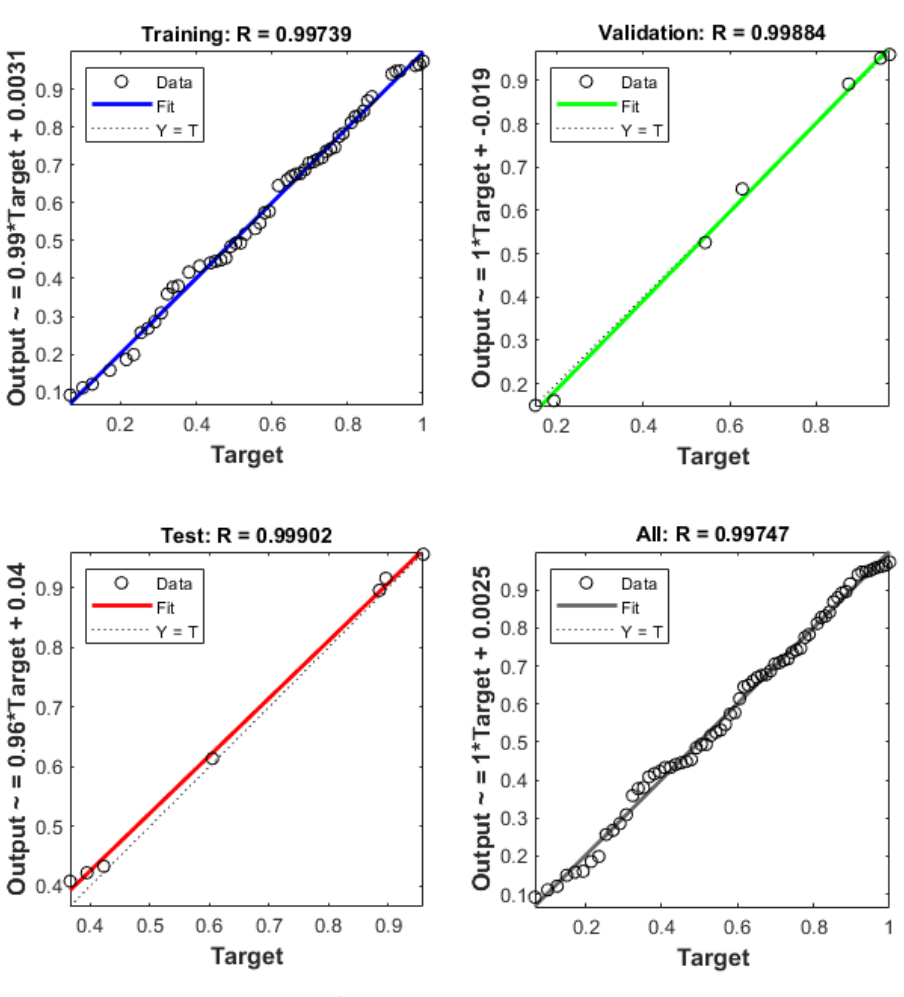
Figure 10. MLP 1-1-1 regression plot.